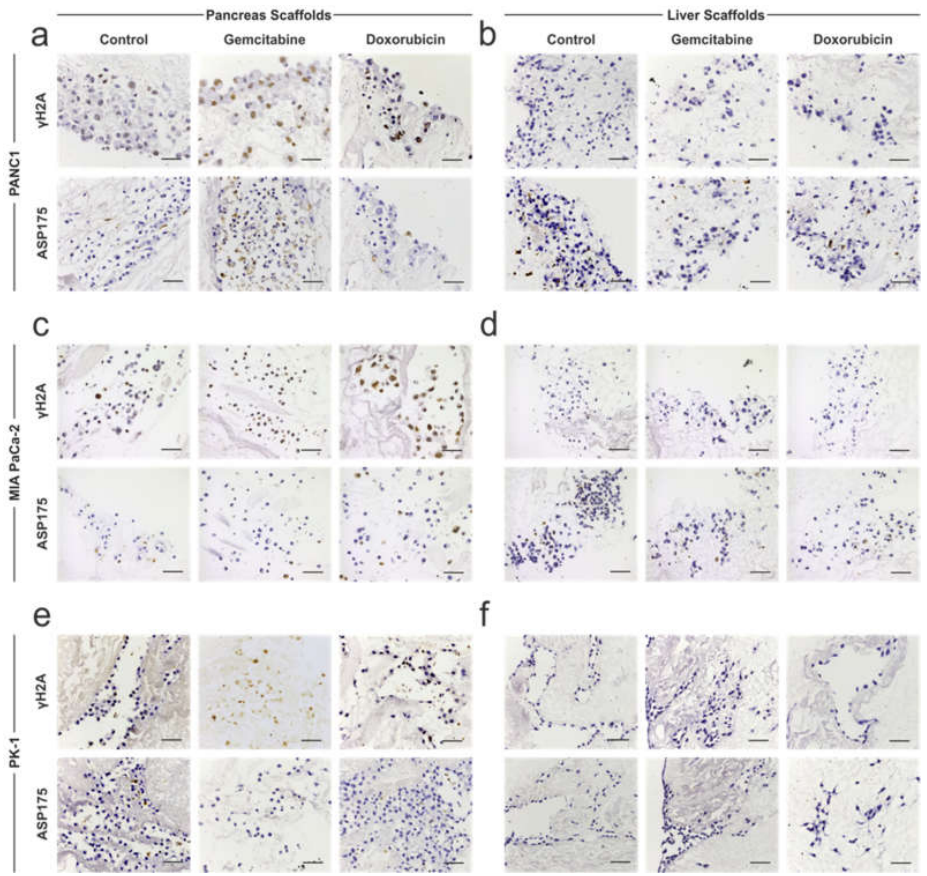
Figure 5. Immunohistochemistry analysis of chemotherapy-treated PDAC cells cultured on 3D scaffolds. PDAC cells cultured on 3D scaffolds were left untreated (control) or treated with 0.5 µ M gemcitabine and 0.5 µ M doxorubicin and stained for γ H2A (top panels) or ASP175 (bottom panels). ( a ) γ H2A staining of PANC-1 cells on pancreas scaffolds stained negative on the control samples but were positive on the gemcitabine- and doxorubicin-treated samples. There was no difference in staining of ASP175 between the different conditions. ( b ) γ H2A and ASP175 staining of PANC-1 cells on liver scaffolds were negative in all conditions. ( c ) MIA PaCa-2 cells on pancreas scaffolds stained for γ H2A were negative in the control samples but was positive in the gemcitabine- and doxorubicin-treated samples. There was no difference in staining of ASP175 between the different conditions. ( d ) MIA PaCa-2 cells on liver scaffolds stained for γ H2A and ASP175 were negative in all conditions. ( e ) PK-1 cells on pancreas scaffolds stained for γ H2A were negative in the control sample but was faintly positive in the gemcitabine-treated sample and moderately positive in the doxorubicin-treated sample. All conditions showed a negative staining for ASP175. ( f ) PK-1 cells on liver scaffolds, stained for γ H2A and ASP175, were negative in all conditions. Scale bars are representative of 100 µ